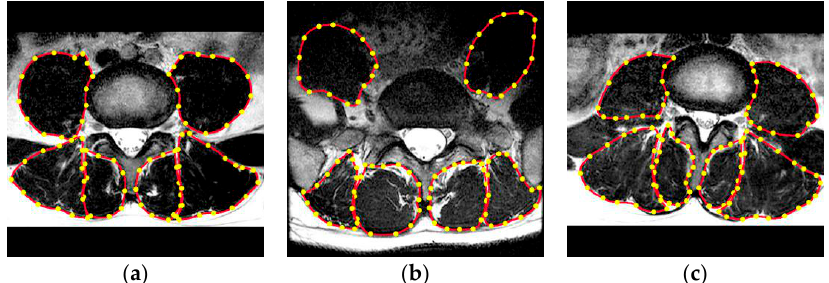
Figure 1. ( a – c ) Experts manually construct the outer edge polygon points (yellow) around each muscle. The area enclosed by the red curve connected by the yellow dots indicates the cross-sectional area (CSA) of each muscle.